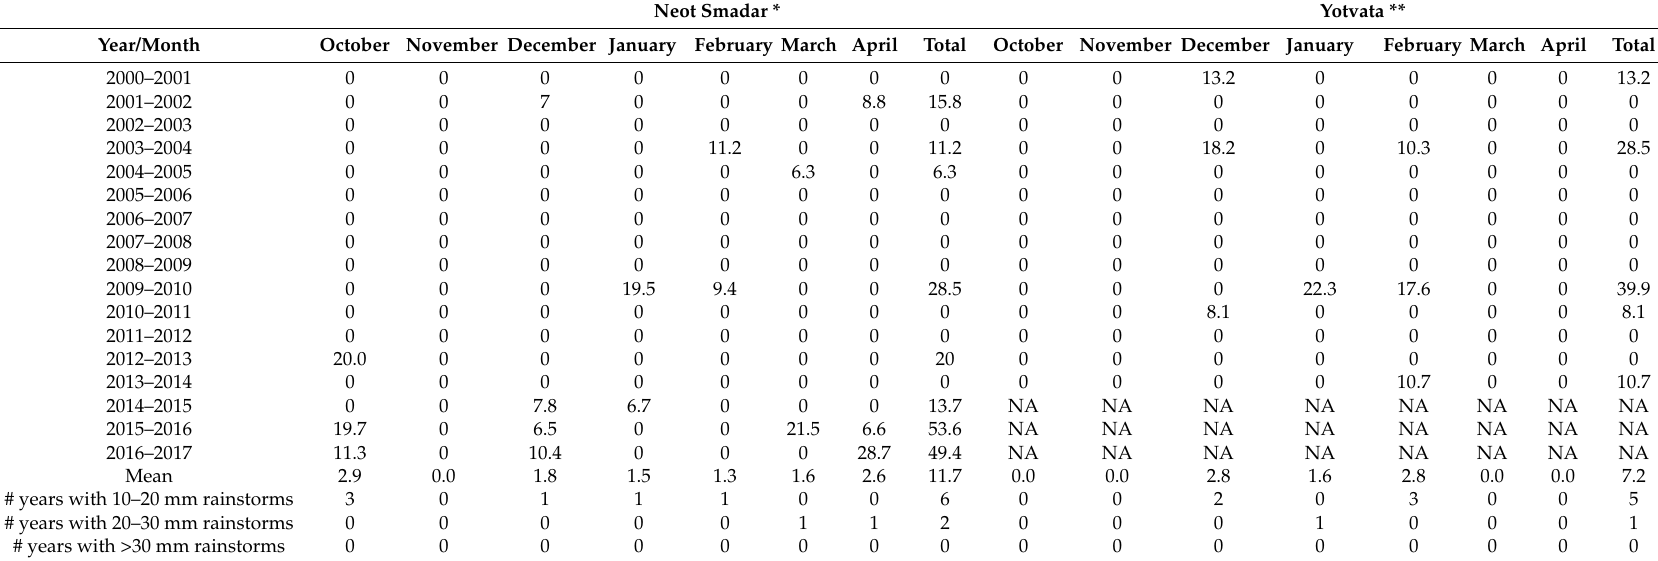
Table 2. Long-term data of the depth (mm) of effective rainstorms (>6 mm) for the Neot Smadar and Yotvata meteorological stations. Neot Smadar